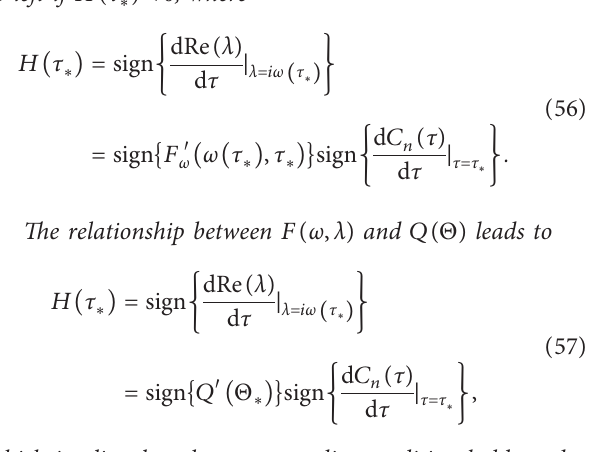
Figure 4: The stability of the computer virus equilibrium E (b) Θ 2 � 0.4363 and Q( Θ 2) �